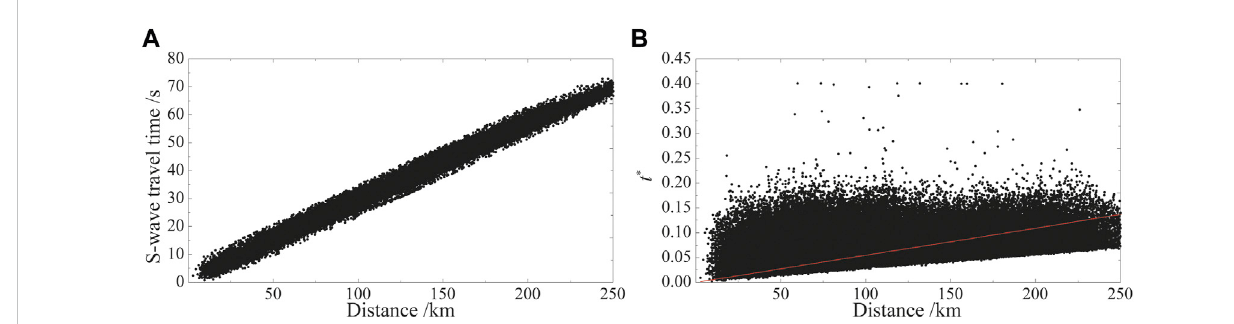
FIGURE 4 Linear fi t of (A) arrival time difference (ATD) and (B) attenuation operator ( t *) data to the epicentral distance.